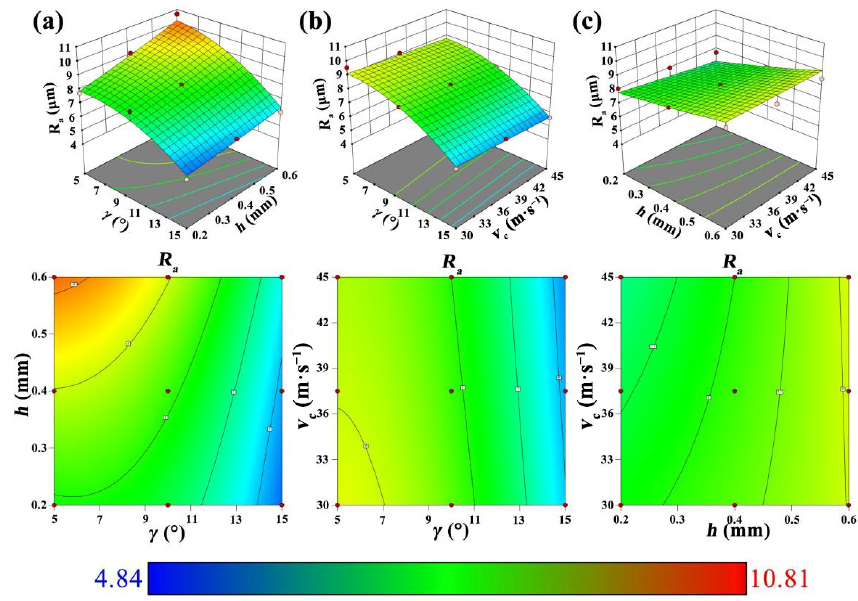
Figure 7. Two-level interactions on surface roughness: ( a ) rake angle and depth of cut ( b ) rake angle and cutting speed and ( c ) cutting speed and depth of cut.